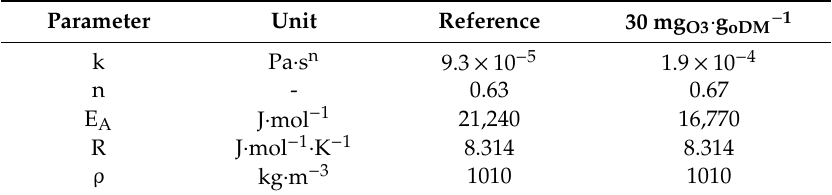
Table 2. Mean rheological parameters of digestate centrate with and without ozone treatment.